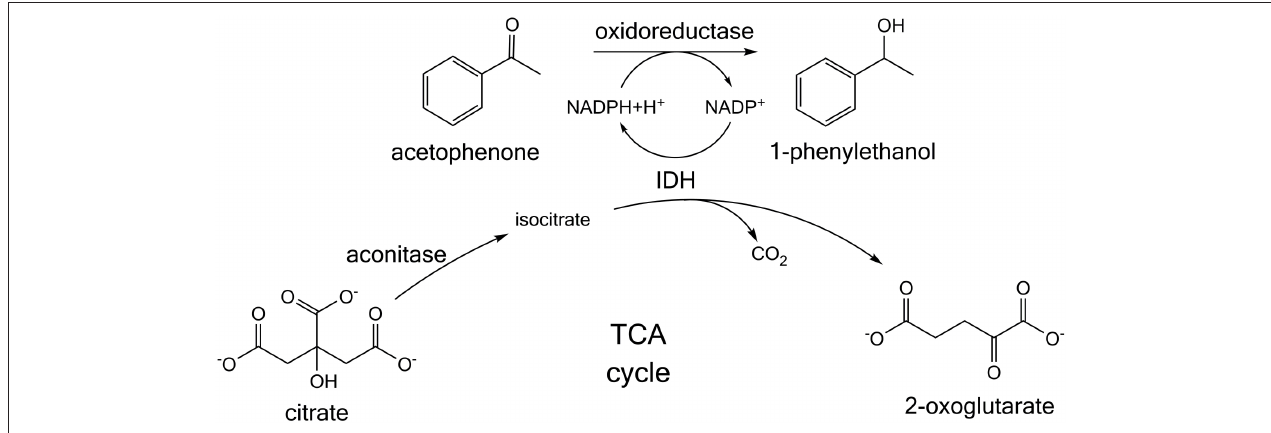
FIGURE 1 | Citrate-dependent cofactor regeneration approach for screening NADPH-dependent oxidoreductases. Acetophenone is converted to 1-phenylethanol. In the reaction NADPH is consumed, which is proposed to be regenerated by the tricarboxylic acid (TCA) cycle enzymes present in whole cells or crude cell extract. Citrate is isomerized to isocitrate and then further converted by the enzyme isocitrate dehydrogenase (IDH). In this process IDH regenerates NADPH.